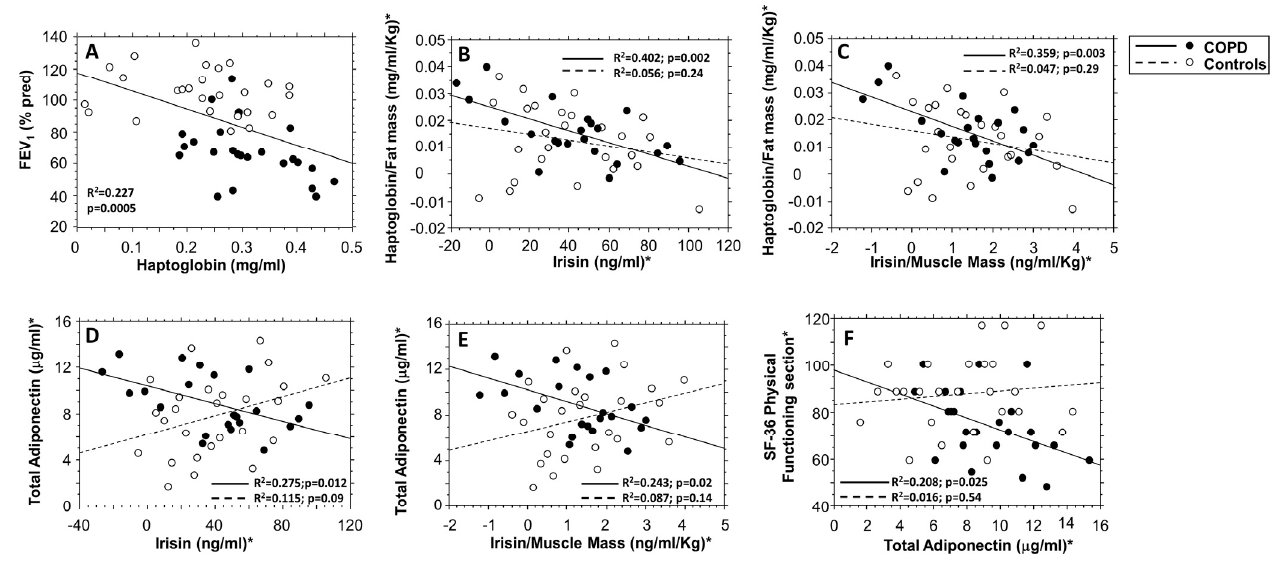
Figure 5. For both COPD and control groups, inverse correlations between FEV 1 (as percent of predicted) and haptoglobin ( A ). Separately for COPD and control groups, inverse correlations between haptoglobin/fat mass and irisin ( B ), haptoglobin/fat mass and irisin/muscle mass ratio ( C ), total adiponectin and irisin ( D ), total adiponectin and irisin/muscle mass ( E ), Physical Functioning section of SF-36 questionnaire and total adiponectin ( F ). * All the variables in panels ( B – F ) were normalized by mean and standard deviation. Table 3. Multiple linear regression model for 6 min walking test. R 2 = 0.701.